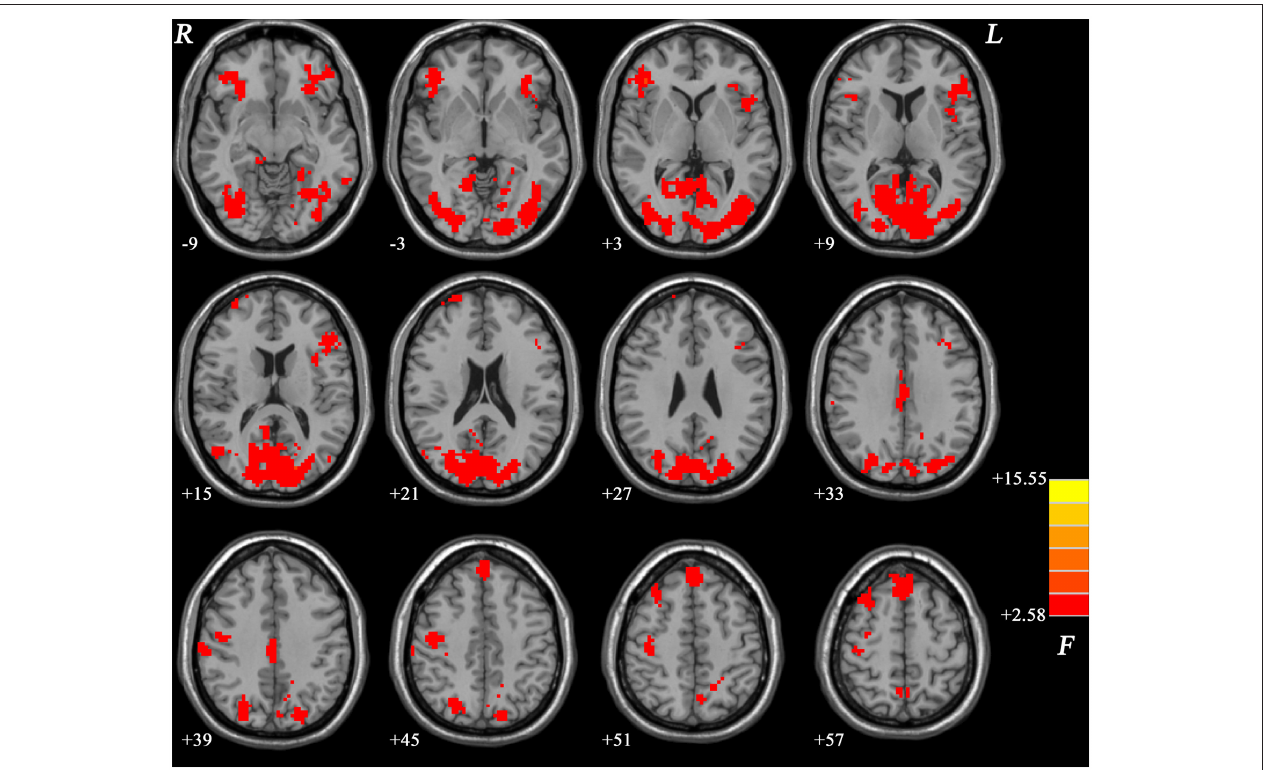
FIGURE 1 | Brain regions showing significantly different fALFF values across three groups at a false discovery rate (FDR)-corrected p < 0.05. The color bar indicates the F values based on ANCOVA. fALFF , fractional amplitude of low-frequency fluctuation; ANCOVA , analysis of